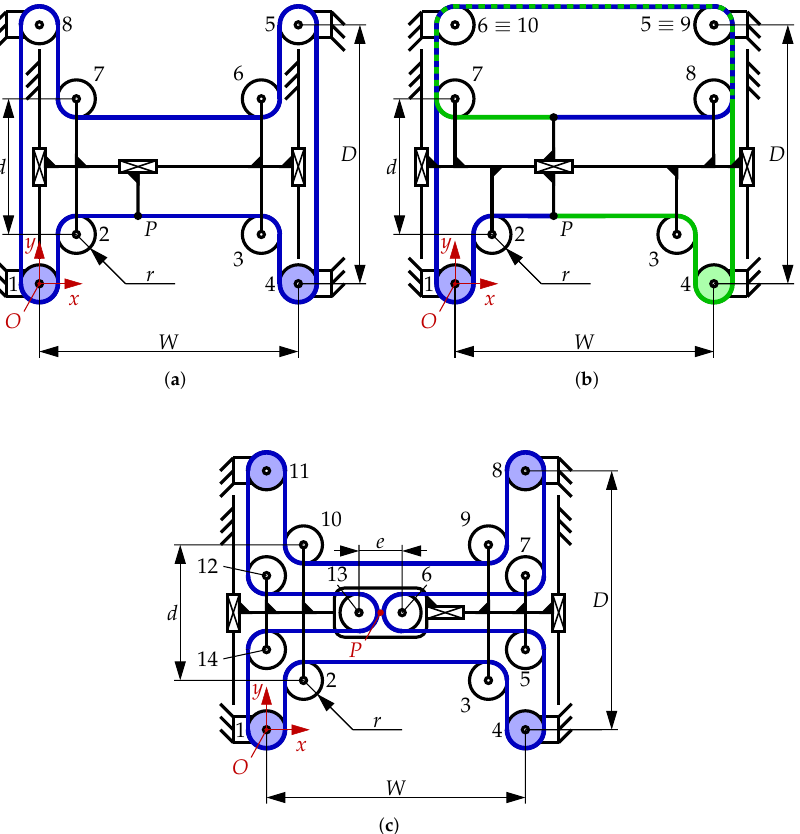
Figure 6. Comparison of the schematics of the three routings: ( a ) H-bot, ( b ) CoreXY, ( c ) CoreH-bot. Here, the CoreXY schematic ( b ) is simplified with respect to Figure 4: pulleys 6 and 9 coincide with pulleys 10 and 5, respectively, thus the two belts partially overlap (over the dashed segments).